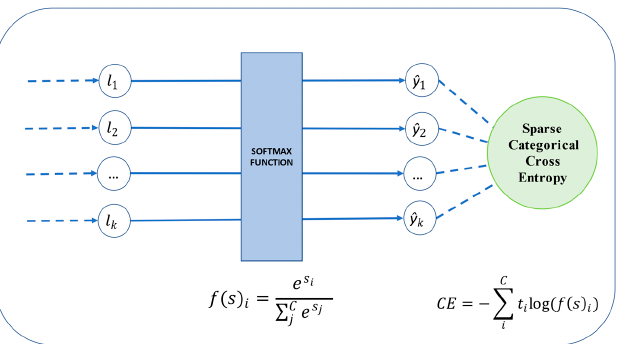
Figure 5. Sparse Categorical Cross Entropy use for multi-categorical classification.